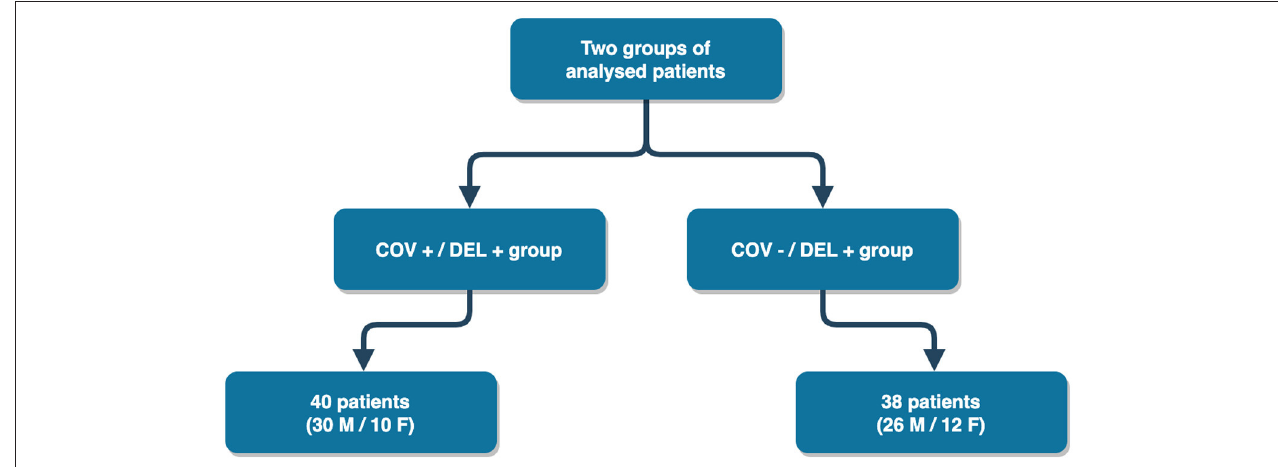
FIGURE 1 | Flowchart depicting the selection process of the